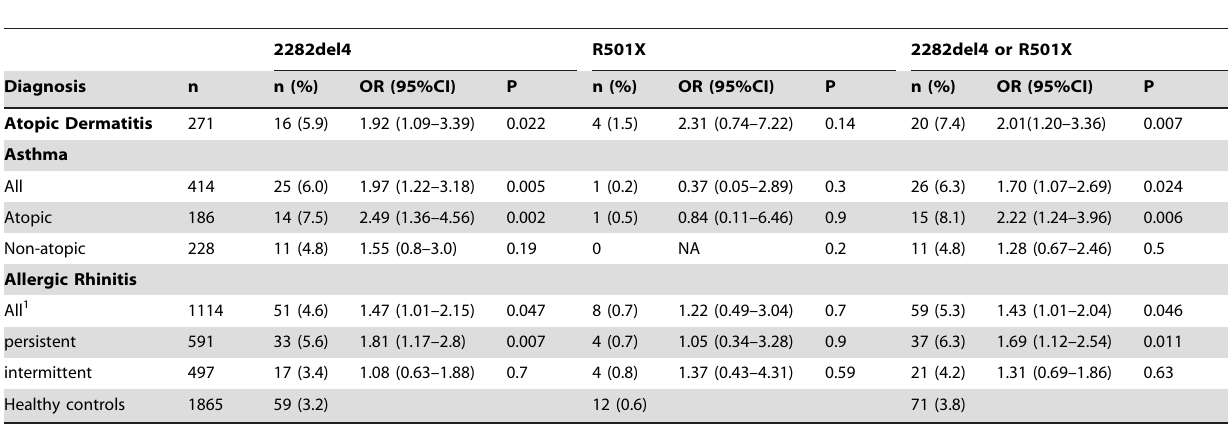
Table 1. Prevalence of FLG variants according to clinical